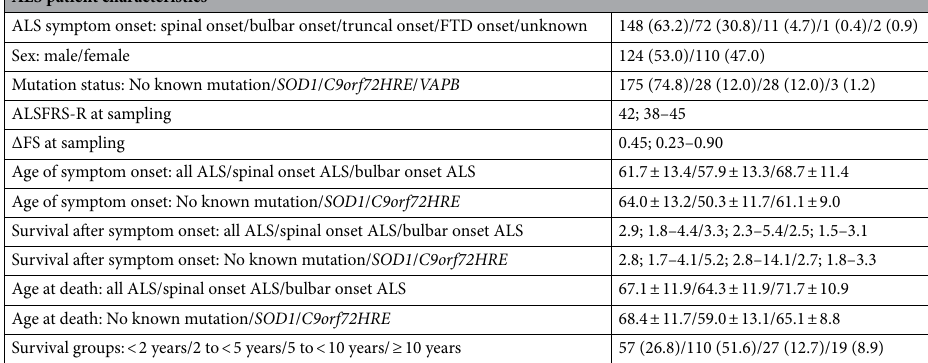
Table 3. ALS patient characteristics. Data are presented as either frequency and percentage, arithmetic mean ± SD or median; Q1–Q3. Age of symptom onset, survival after symptom onset and age at death are presented in